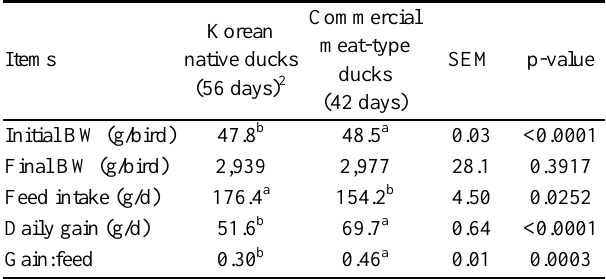
Table 2. Growth performance of the Korean native ducks and